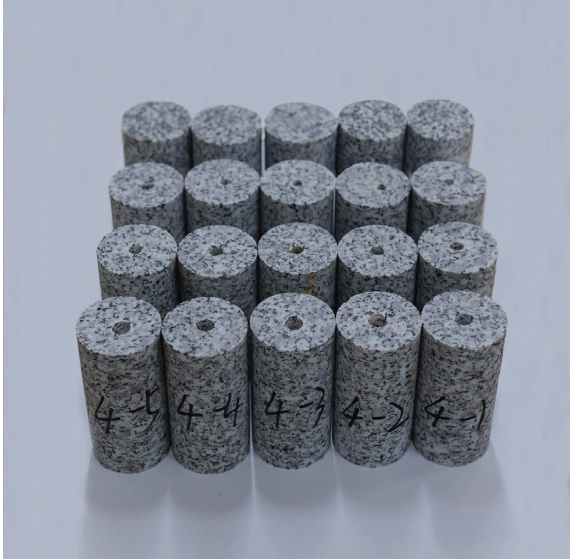
Figure 6: Processed rock